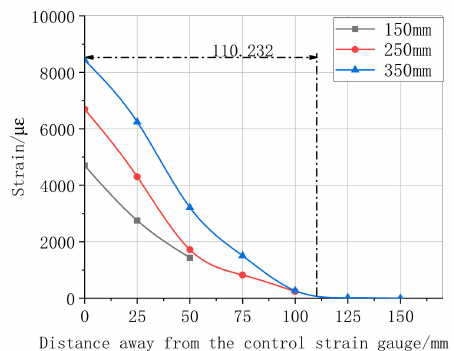
Figure 11. Ultimate strain of di ff erent lengths of CFRP bonding.